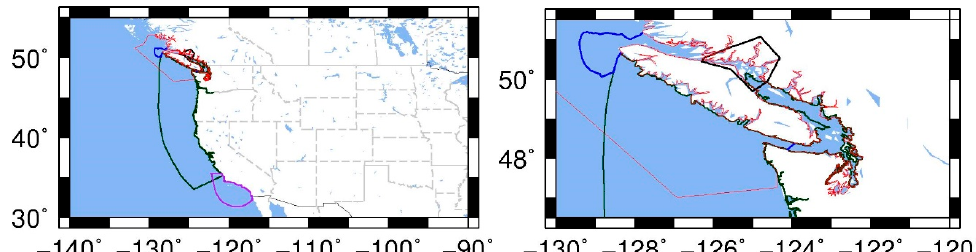
Figure 3. Location of available models for coastal refinement (extents only); global view (left panel) and zoom of Vancouver Island region (right panel): Southern California VDatum (purple), Pacific Northwest VDatum (dark green), Vancouver Island (red), Discovery Passage model (thick black), and location for merging Vancouver boundaries (thick blue).